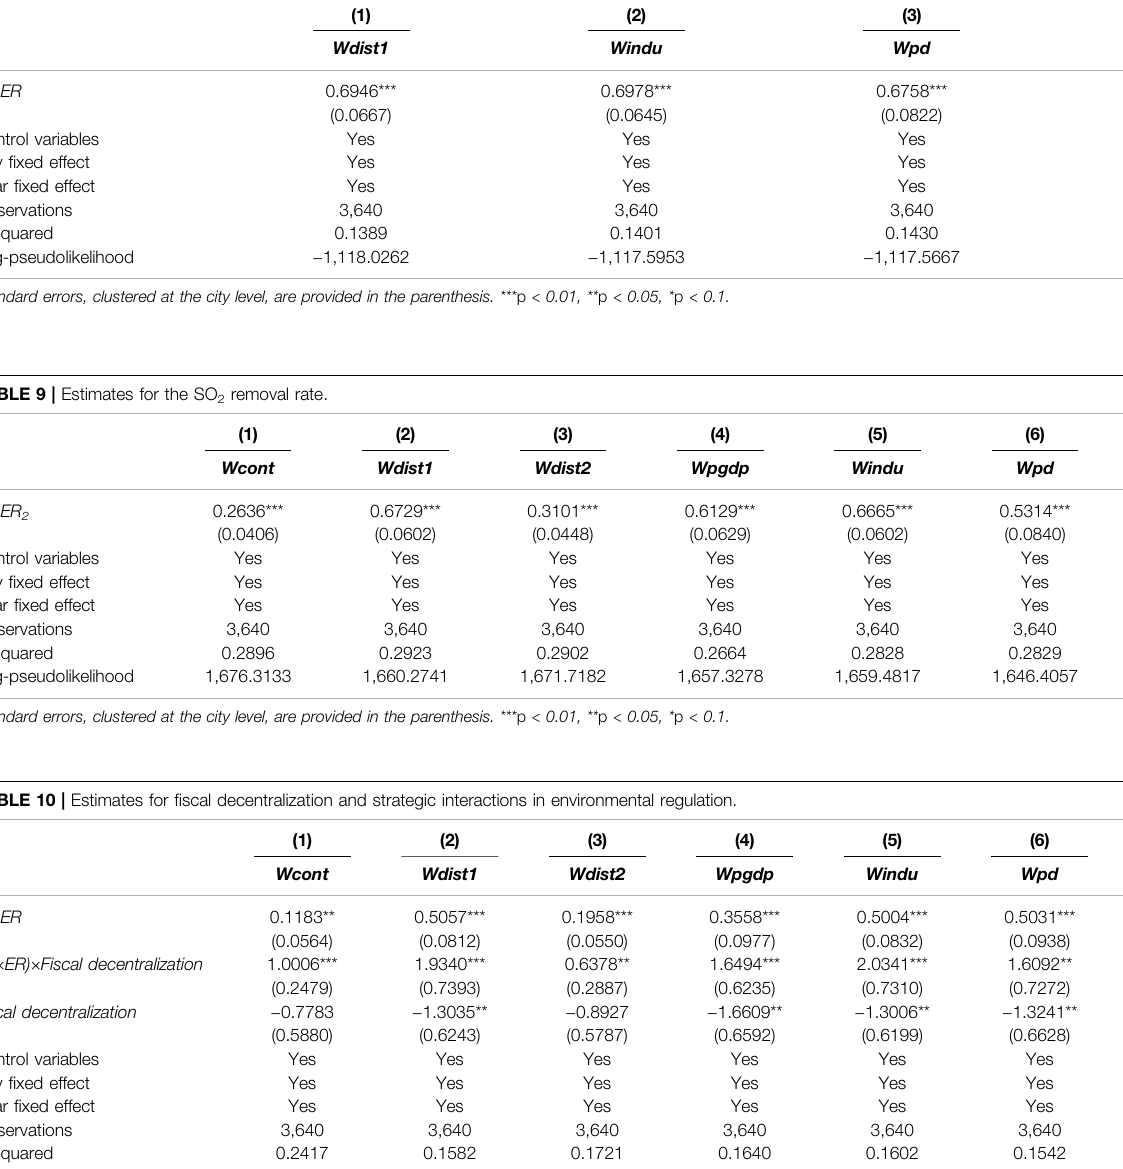
baseline model. The corresponding results are reported in Table 11 .